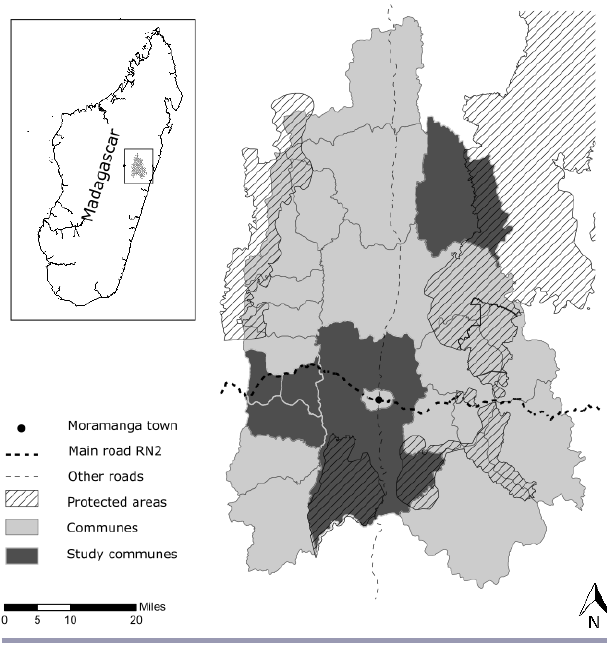
Fig. 1 . Moramanga district and study communes. Inset: position of Moramanga district in